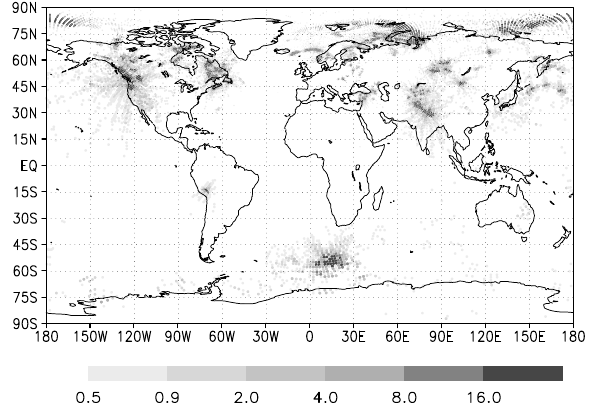
Fig. 7. Temperature (in Kelvin) in one model point on the 12 lowest model levels for each time-step during the 96 hour forecast for the model run with the fibrillation amplification test of the large scale precipitation scheme.